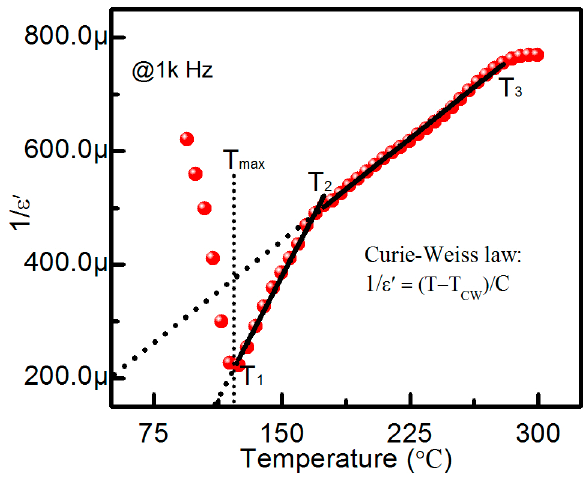
Figure 8. The fitting of the Curie–Weiss law of PLN-0.07PT single crystals.